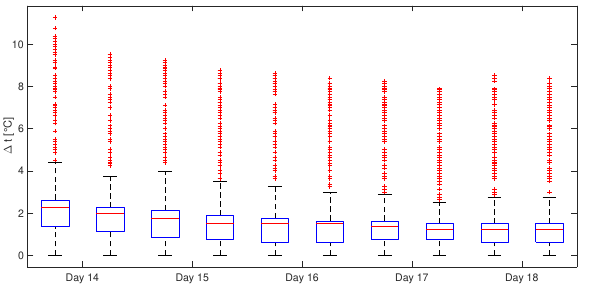
Figure 18. Box plot—measured temperature difference between Compost—Out and Compost—In. Average volumetric flow rate measured using water meter for this period reads 5.029